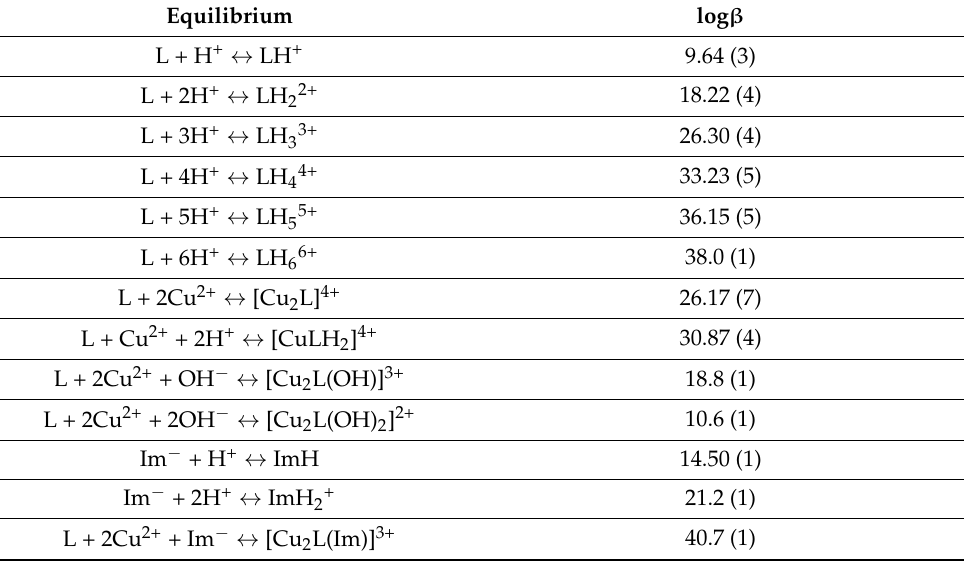
Table 1. Global constants for the protonation and complexation equilibria studied in this work. The constants were determined through potentiometric titrations on BPXD (i.e., L in this table) in aqueous solution, 0.05 M CF 3 SO 3 Na, T = 25 ◦ C. The protonation equilibria for ImH were investigated in the same conditions as for BPXD; the obtained results are consistent with the literature